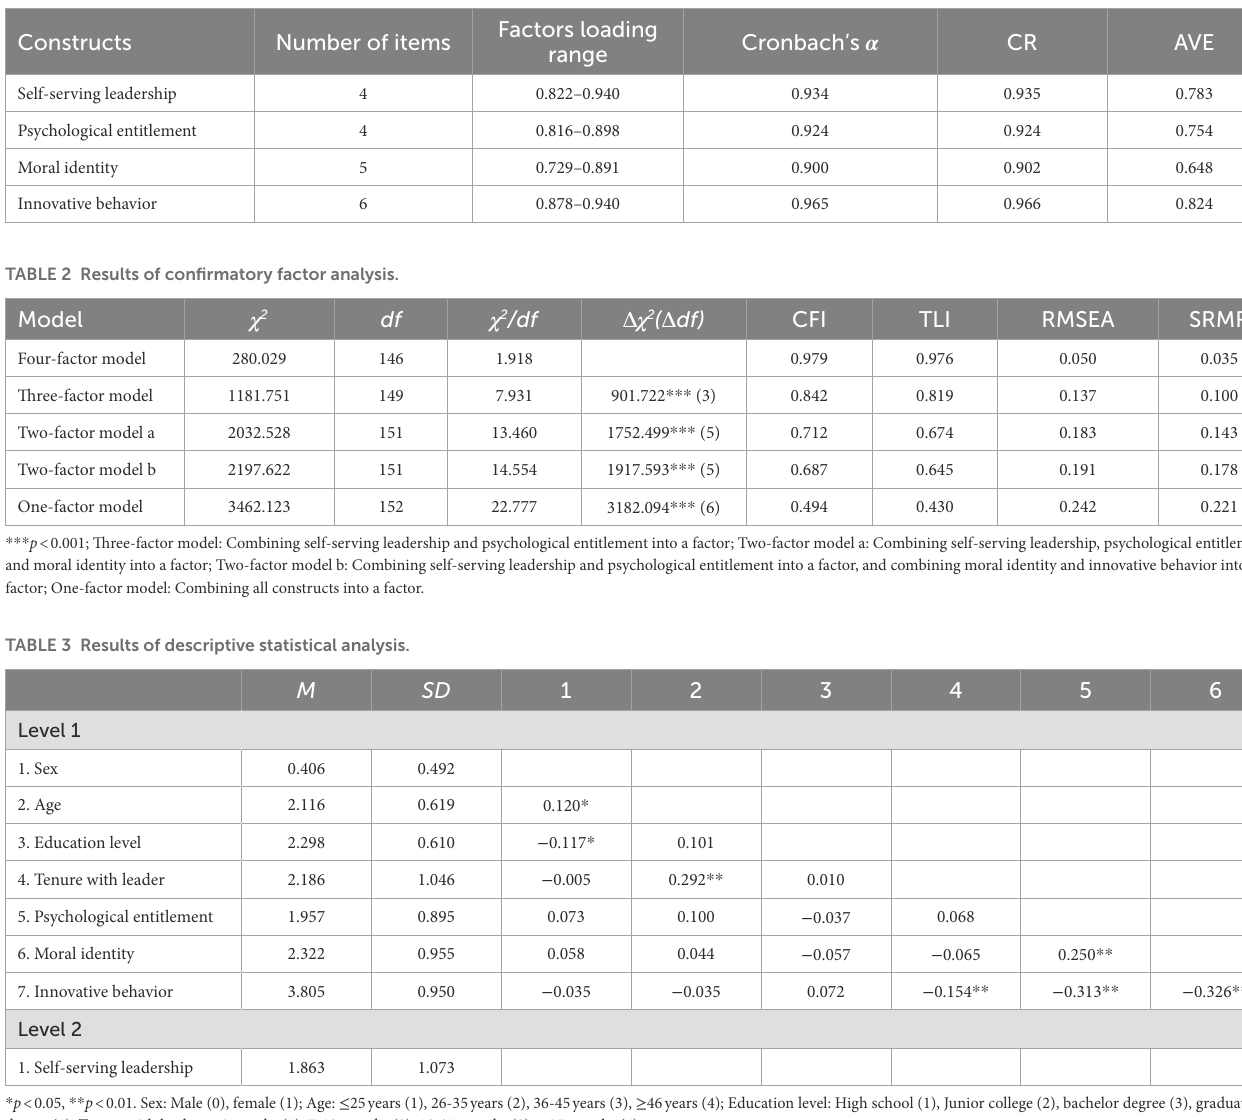
TABLE 1 Results of reliability and validity analysis.